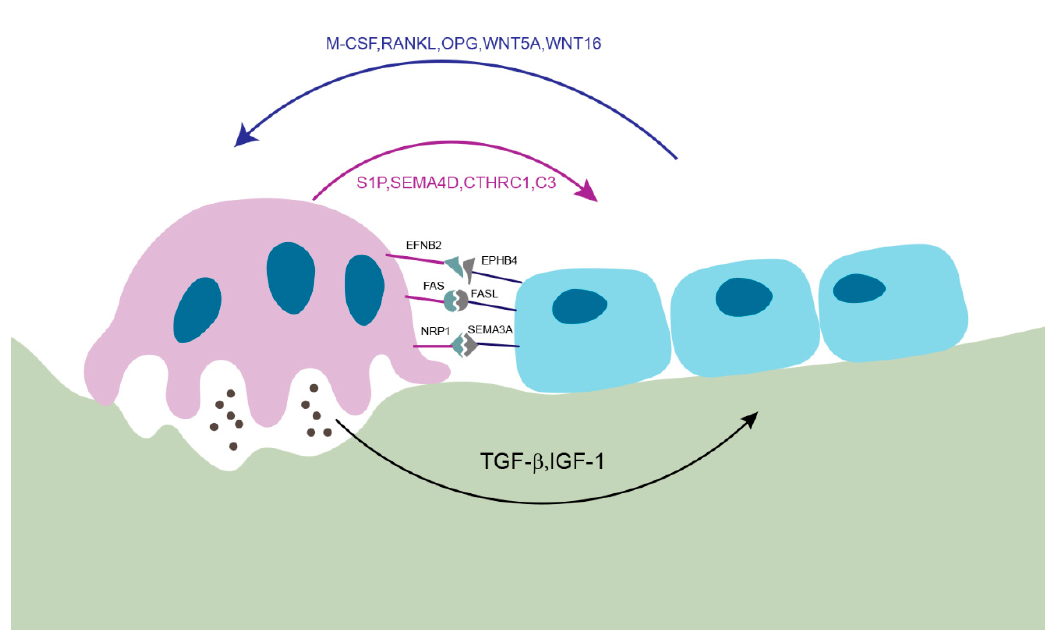
Figure 2. Key mediators of osteoblast-osteoclast interaction. Osteoblast-osteoclast communications are essential for fine-tuning of bone remodeling during bone homeostasis. (1) Osteoblasts and osteoclasts have direct contacts through the interactions between EFNB2-EPHB4, FAS-FASL and NRP1-SEMA3A to regulate cell proliferation, differentiation, and survival. (2) Osteoclast-mediated bone resorption releases TGF- β and IGF-1 from bone matrix to induce osteoblast-mediated bone formation. (3) Osteoblasts secrete M-CSF, RANKL, WNT5A that promote osteoclast formation and development and OPG and WNT16 that inhibit osteoclast activity. Conversely, osteoclasts secrete S1P, CTHRC1 and C3 that promote osteoblast differentiation and SEMA4D that suppresses osteoblasts differentiation. The factors which control osteoblast–osteoclast communication will be reviewed in cellular